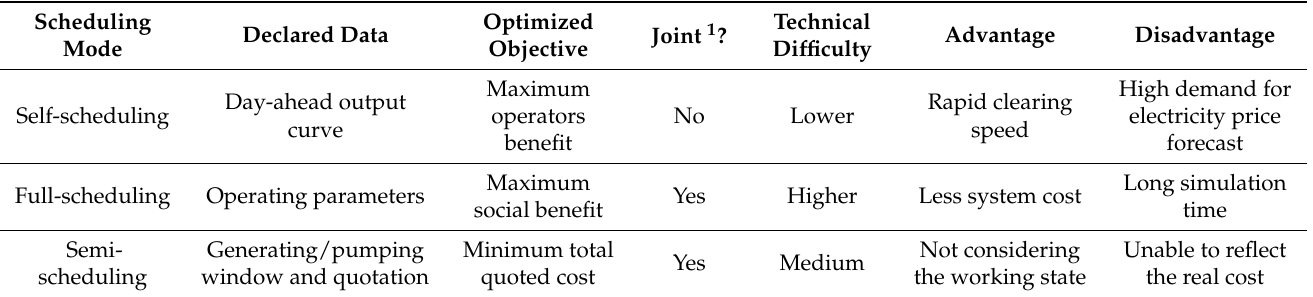
Table 1. Comparison of Pumped Storage Scheduling